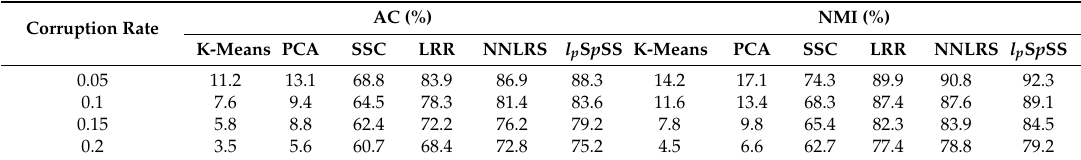
Table 5. Segmentation results of proposed and existing methods on Extended Yale B with pixel corruptions.